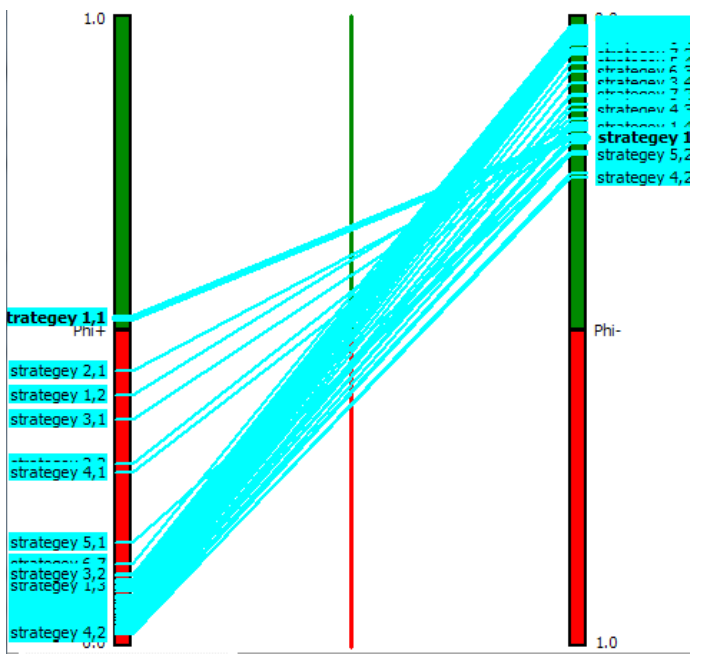
Figure 3. PROMETHEE I at Assumption